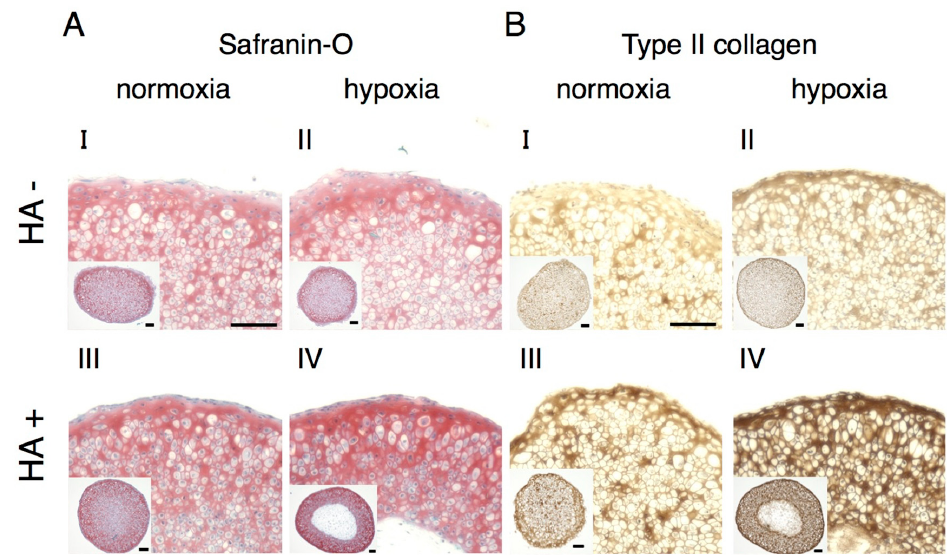
Figure 3. Exogenous HA promotes the redifferentiation of rat articular chondrocytes (rACs) and the synthesis of hyaline cartilage ECM under hypoxic conditions. Rat primary articular chondrocytes